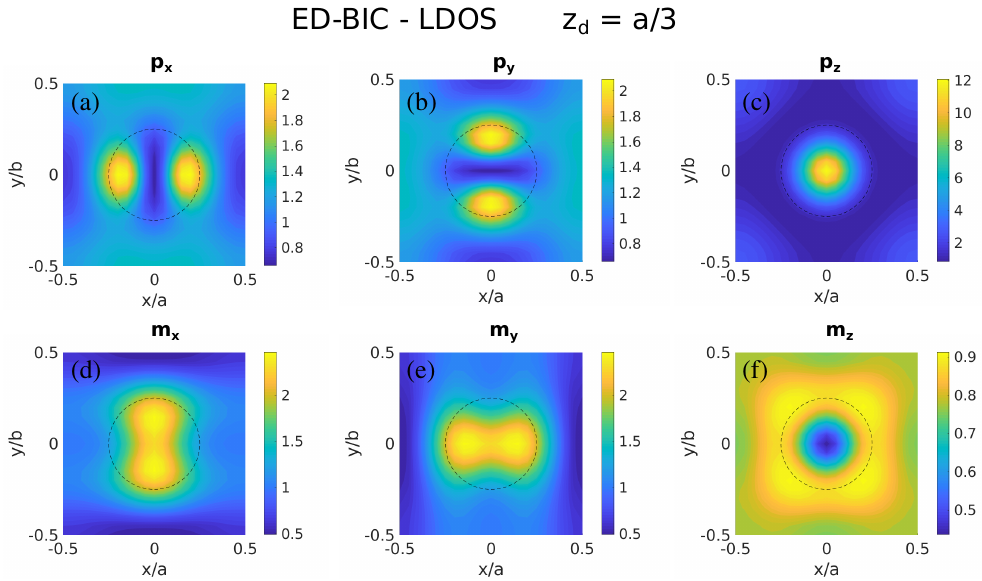
Figure 2. Color maps of the local density of states (LDOS) for the Si nanosphere metasurface shown in Figure 1a, at the wavelength of the symmetry-protected ED-BIC ( λ = 552 nm; see Figure 1e) within one unit cell at a distance of z d = a /3 ≈ 133 nm, corresponding to the different electromagnetic dipolar contributions: ( a ) p x , ( b ) p y , ( c ) p z , ( d ) m x , ( e ) m y , ( f ) m z . The projection of the nanosphere cross section on the plane is denoted by a dashed